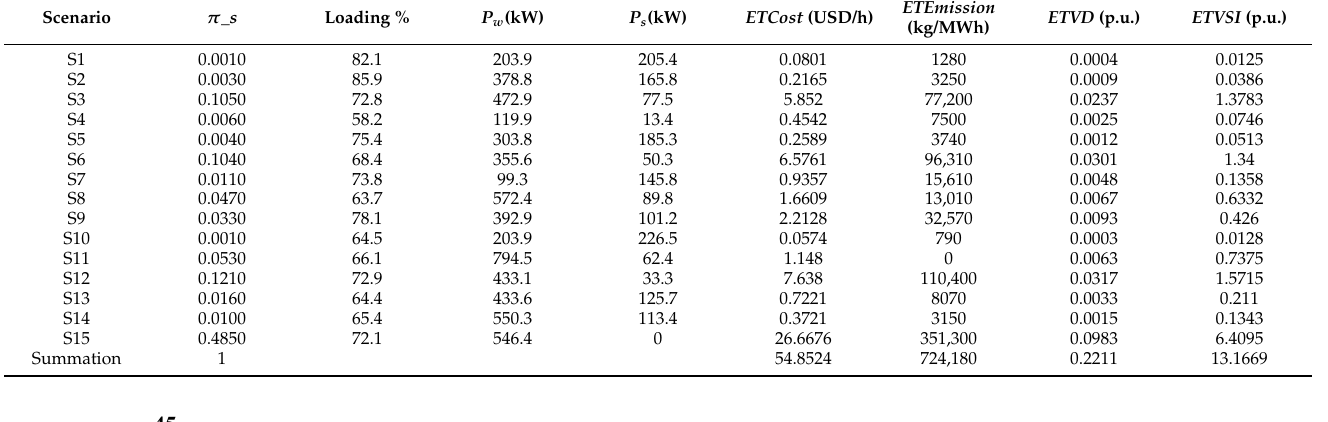
Table 10. The 15-bus system simulation results.